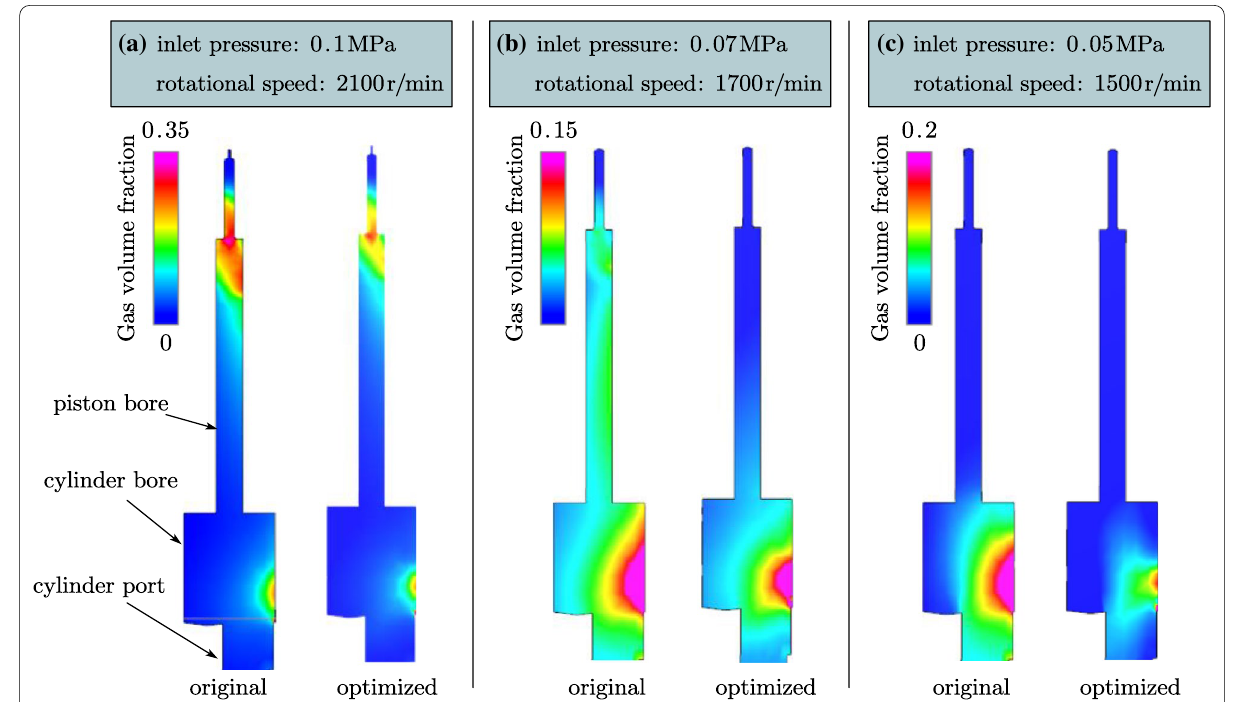
Figure 12 Comparison of the two-dimensional cavitation region in the piston chamber with the original and optimized suction duct